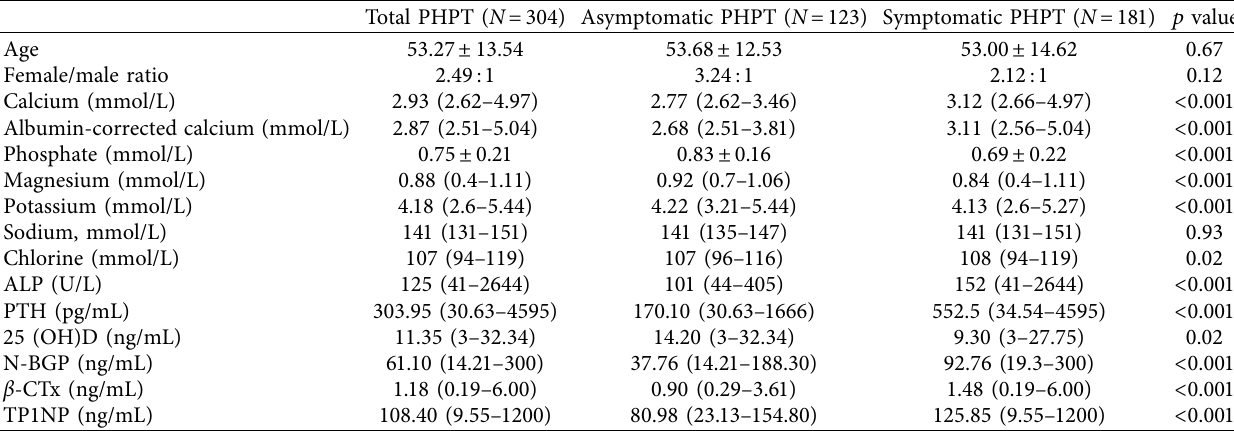
Table 1: Comparison of clinical feature and laboratory values between asymptomatic PHPT patients and symptomatic PHPT